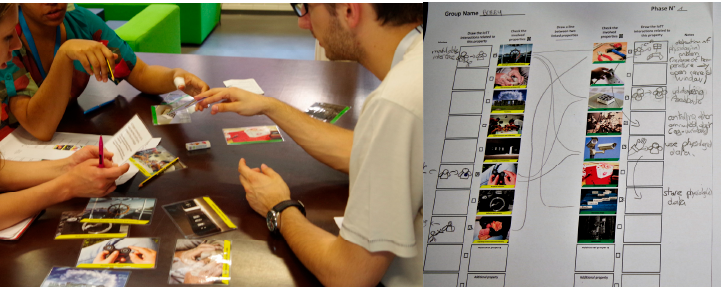
Figure 5. Participants using the card set during the workshop ( left ); tangible and IoT properties and links annotated by participants of the Bobby group ( right ).